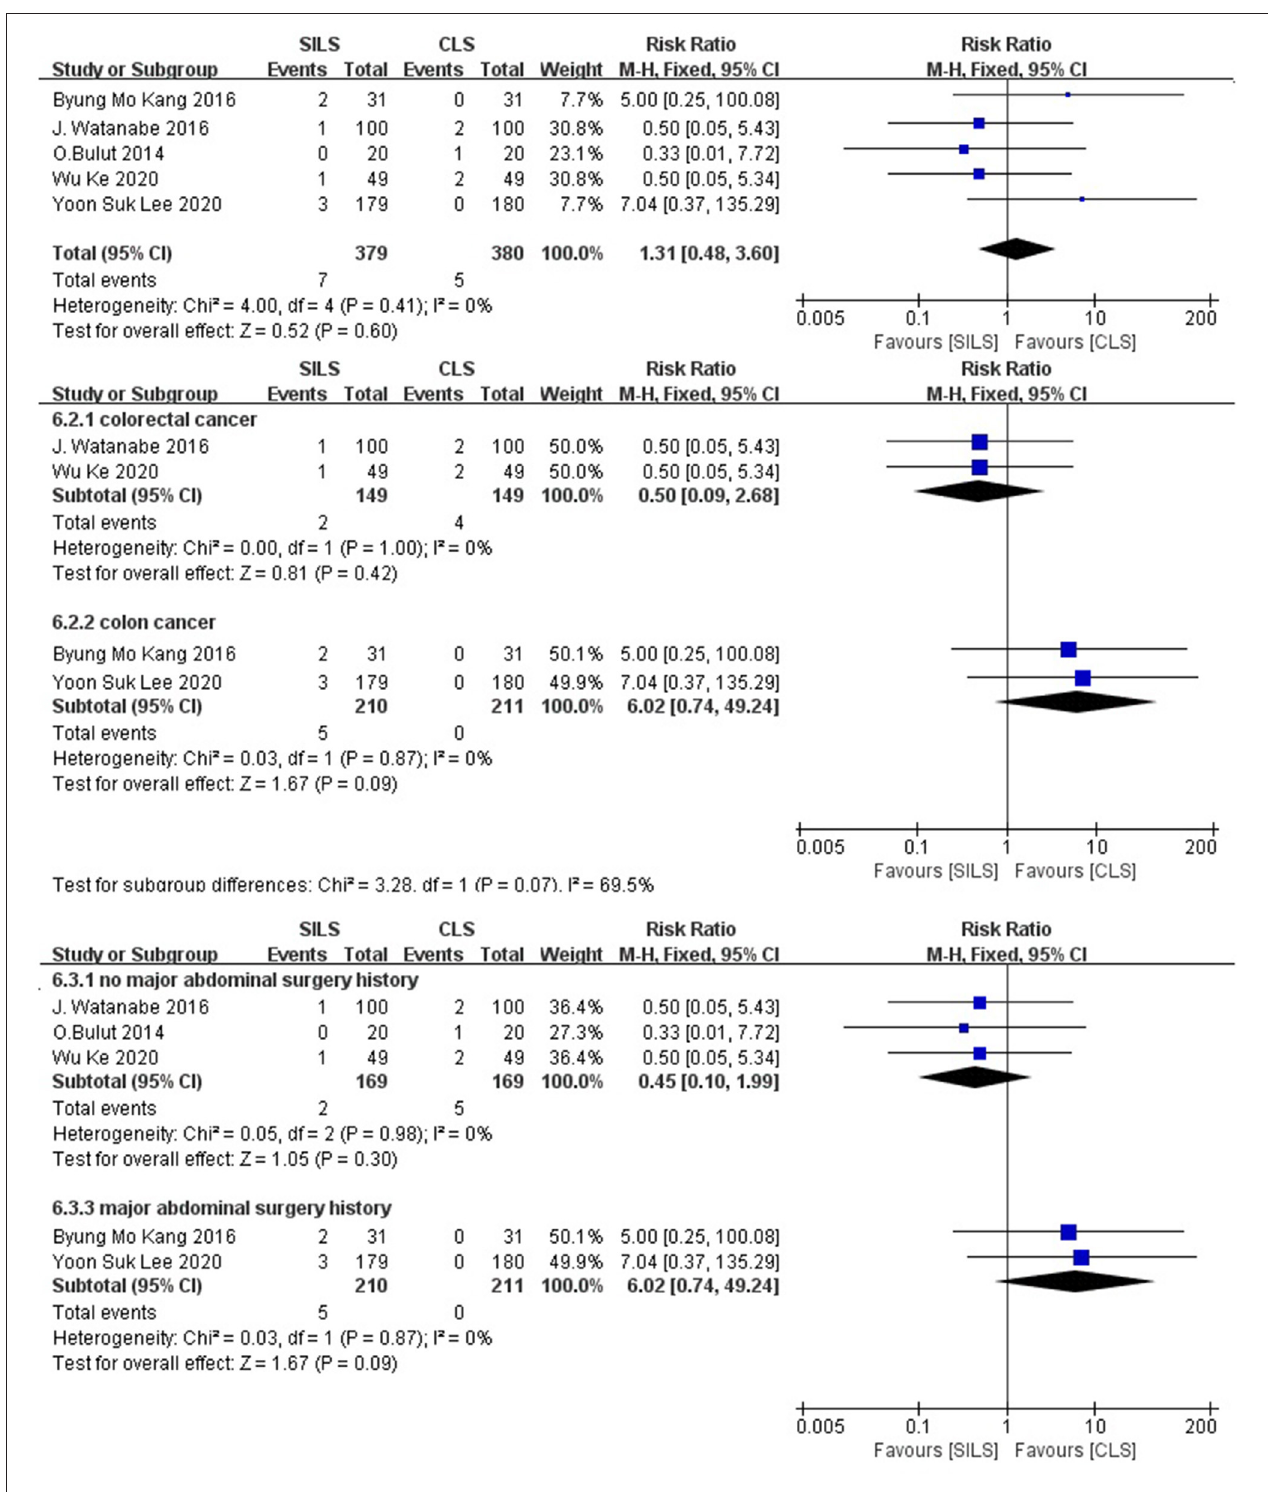
FIGURE 7 | Meta-analysis of conversion to laparotomy. SILS, single-incision laparoscopic surgery; CLS, conventional laparoscopic surgery.